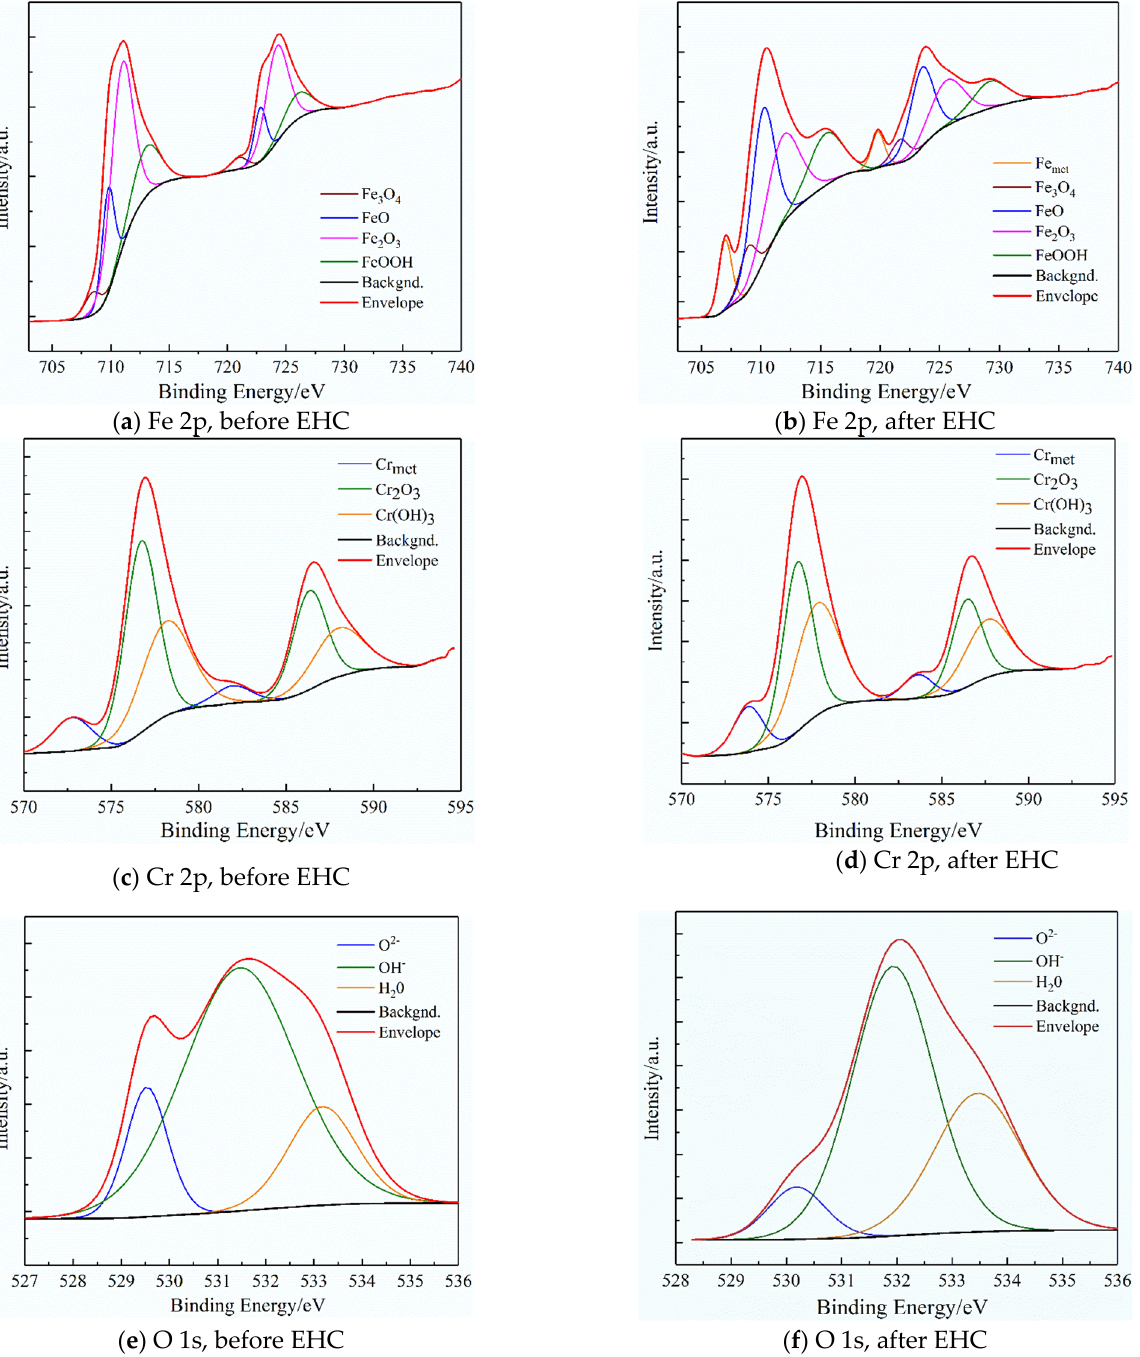
Figure 3. XPS spectra for passive film on the surface of 321 stainless steel before and after EHC (1 mA/cm 2 ). As seen, Fe elements mainly exist in the form of Fe 2 O 3 , FeOOH, FeO and a little Fe 3 O 4 in the passive film before EHC. The peak of Fe 2 O 3 decreases and its content decreases from 59.66% to 28.96% after EHC for 3 h. At the same time, the contents of Fe 3 O 4 and FeO increase from 5.19% and 17.00% to 9.17% and 33.28%, respectively. Obviously, hydrogen charging reduces the Fe 3+ content and increases the Fe 2+ content in the passivation film. The difference in the radius of Fe 3+ and Fe 2+ will lead to lattice expansion. Therefore, the stability of the passivation film will reduce under the synergistic action of corrosion and hydrogen